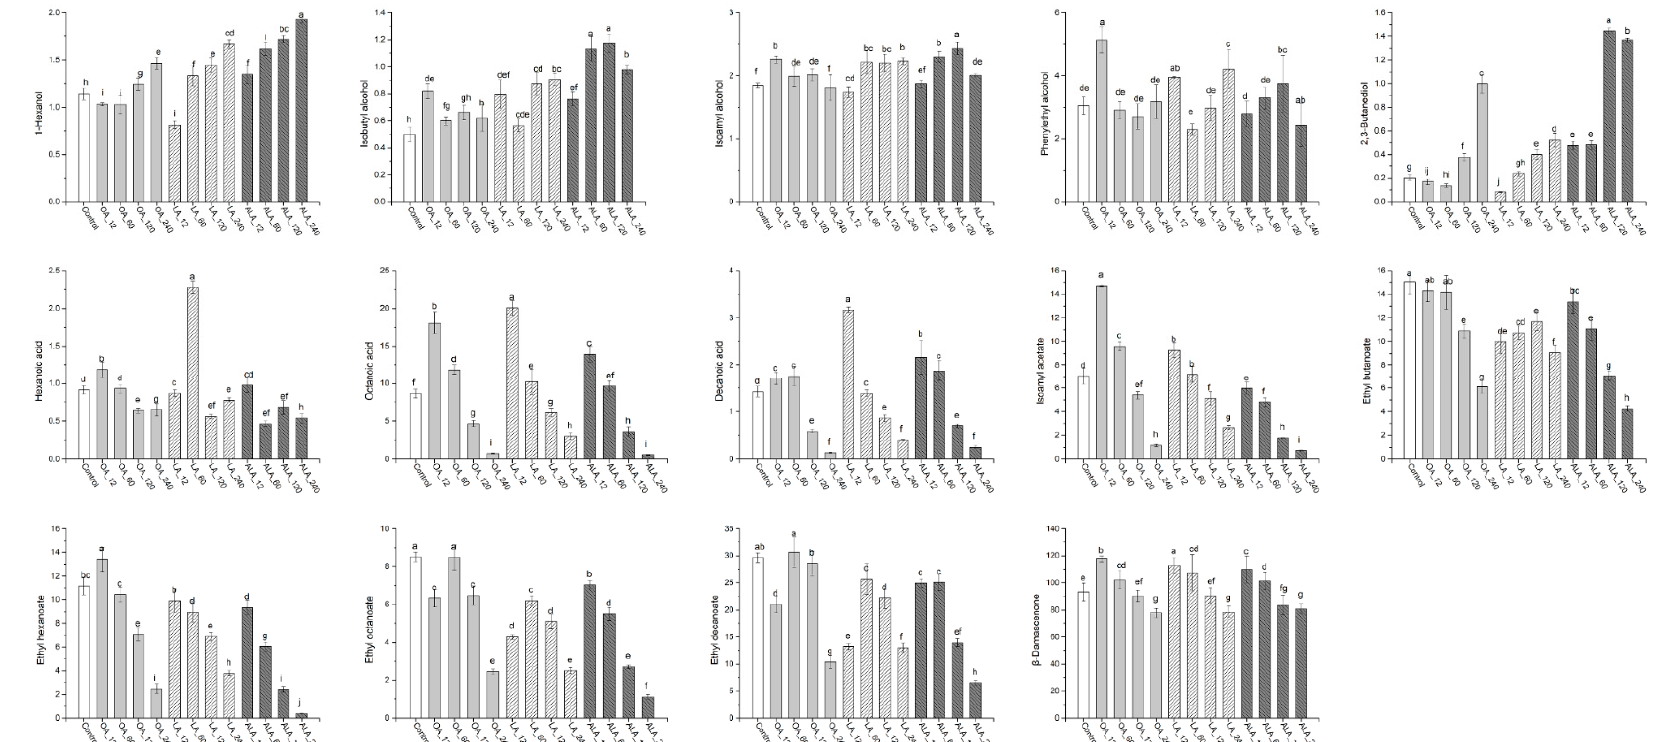
Figure 2. Odour active value (OAV) of main volatile compounds (OAV > 1) in wine with different treatments. Values of the same compound marked with the same lowercase letters indicates no significant difference ( p < 0.05, Duncan’s test).